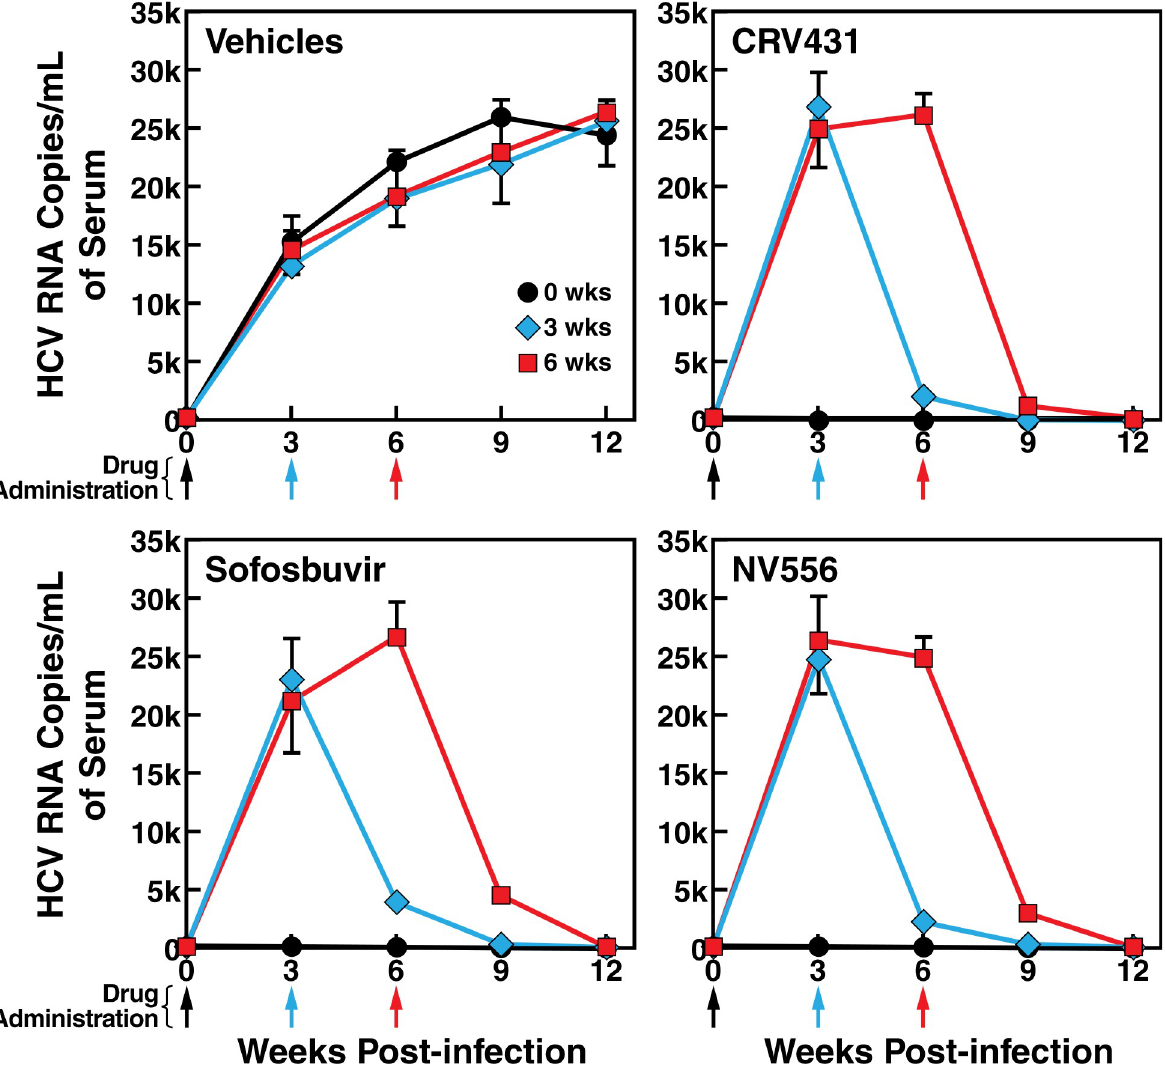
Fig 2. Individual analysis of anti-HCV efficacy of Velpatasvir, Ledipasvir, CRV431 and Alisporivir in humanized-liver chimeric mice. MUP- uPA-SCID-Beige mice implanted with human hepatocytes were infected i.v. with plasma from HCV-infected chimpanzee (100 infectious doses (CID 50 )/mL of GT1a, GT2a, GT3a and GT4a). Drugs (50 mg/kg) were given orally 9 weeks post-infection. Blood was collected retro-orbitally every week until week 15 post-HCV infection. Ten mice per treatment. Viral replication (HCV RNA copies/ml of serum) was quantified by real-time reverse transcription PCR. Error bars corresponds to the standard deviation (SD) between 10 animals. At week 12 and 15 post-infection, SD are small due to the minimal viral loads due to the drug treatment efficacy. Data are representative of two independent experiments.